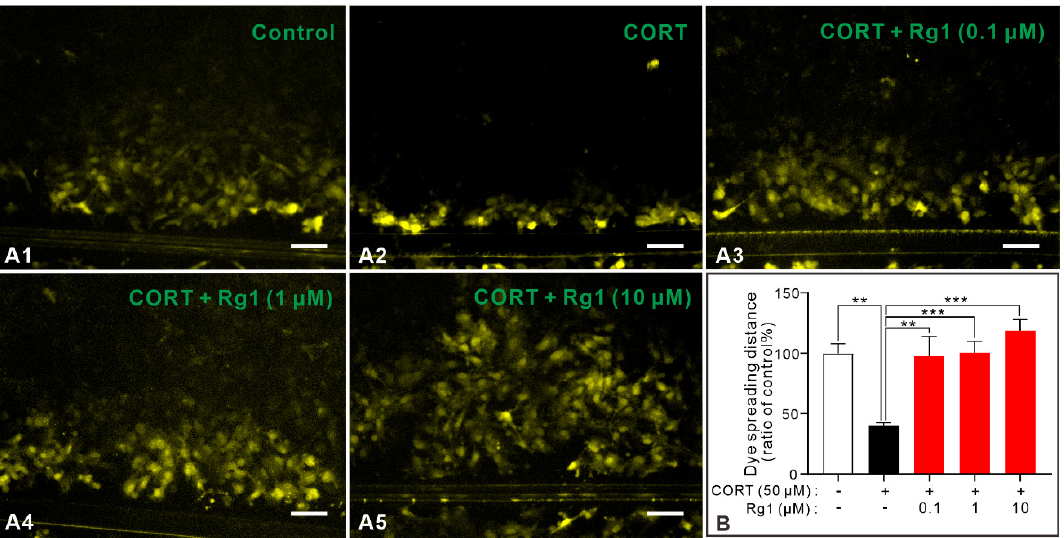
Figure 2. Rg1 ameliorated GJC dysfunction of astrocytes induced by CORT. ( A1 – A5 ) A scrape loading and dye transfer assay was used to assess the transfer of fluorescent Lucifer Yellow into contiguous non-prefrontal cerebral cortical astrocytes. Representative images of fluorescence captured in each group are shown. ( B ) Quantification of the fluorescence diffusion distance was performed using image analysis and expressed as percentages of the control values. CORT treatment decreased the distance of fluorescence dye diffusion, and all three concentrations (0.1, 1, and 10 µM) of Rg1 pretreatment reversed the effect. Data are shown as mean ± SEM ( n = 8). Scar bar: 75 µm. ** p < 0.01; *** p < 0.001. CORT, corticosterone; GJC, gap junction channel.